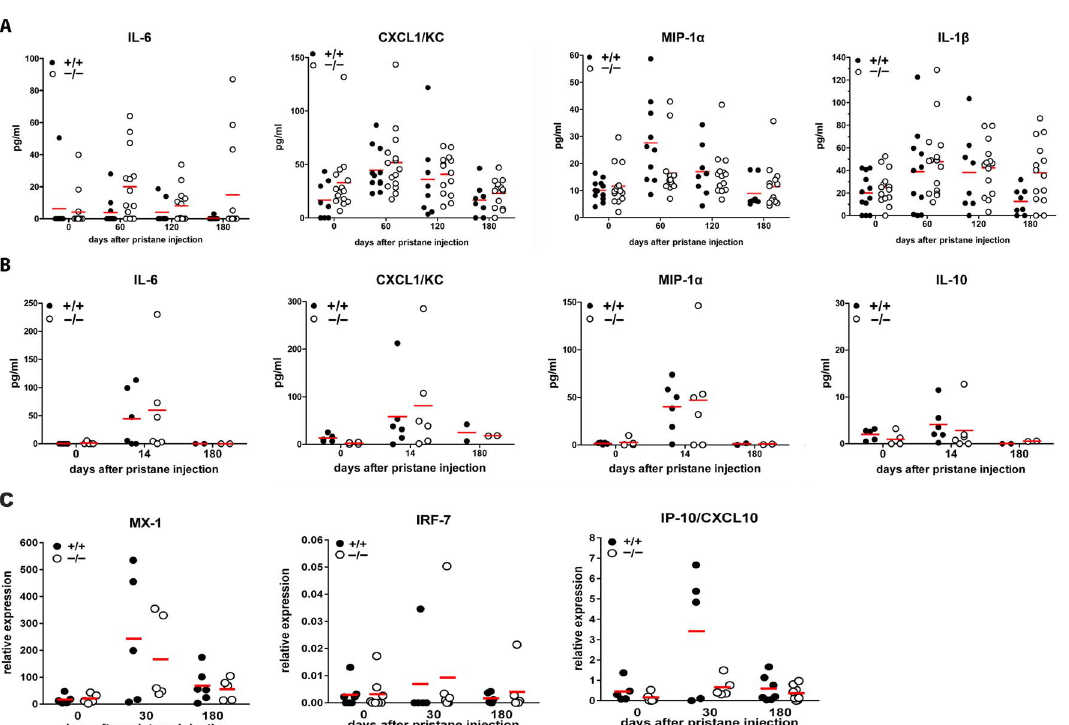
Fig. 5. Cytokine/chemokine levels and expression of ISGs in sera and peritoneal lavages of naı¨ve and pristane-injected mice are not significantly influenced by CRAMP-deficiency. Scatter plots show individual measurements and means from naı¨ve and pristane-injected mice of cytokine/chemokine concentrations in serum (A) or peritoneal lavage (B), or of expression of Interferon I-stimulated genes in serum (C), normalized to b -actin expression. One dot represents one mouse. No significant differences were found by ANOVA with Bonferroni post-hoc